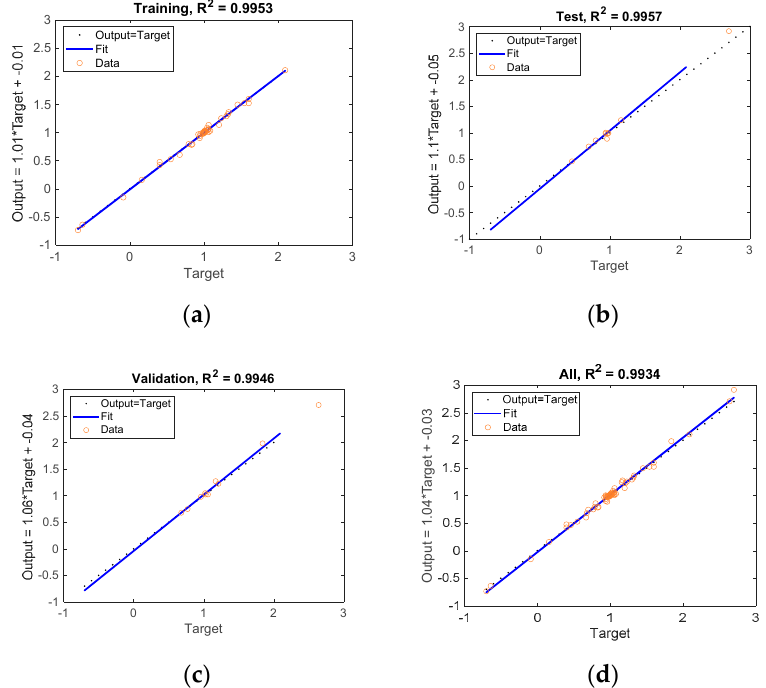
Figure 17. ANN (cid:2871)(cid:2879)(cid:2872)(cid:2879)(cid:2870)(cid:2879)(cid:2869) results for 𝑓 (cid:2870) . ( a ) Train data; ( b ) Validation data; ( c ) Test data, ( d ) All data. Figure 17. ANN 3 − 4 − 2 − 1 results for f 2 . ( a ) Train data; ( b ) Validation data; ( c ) Test data, ( d ) All data.